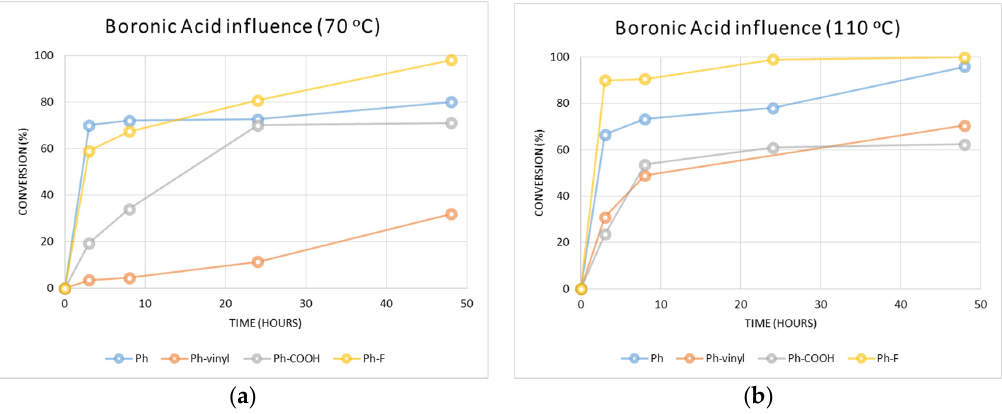
Figure 3. Conversion vs time in the reaction of different boronic acids and 1 ‐ bromo ‐ 4 ‐ fluorobenzene catalyzed by G ‐ COOH ‐ Pd ‐ 10: ( a ) at 70 °C; and ( b ) at 110 °C.